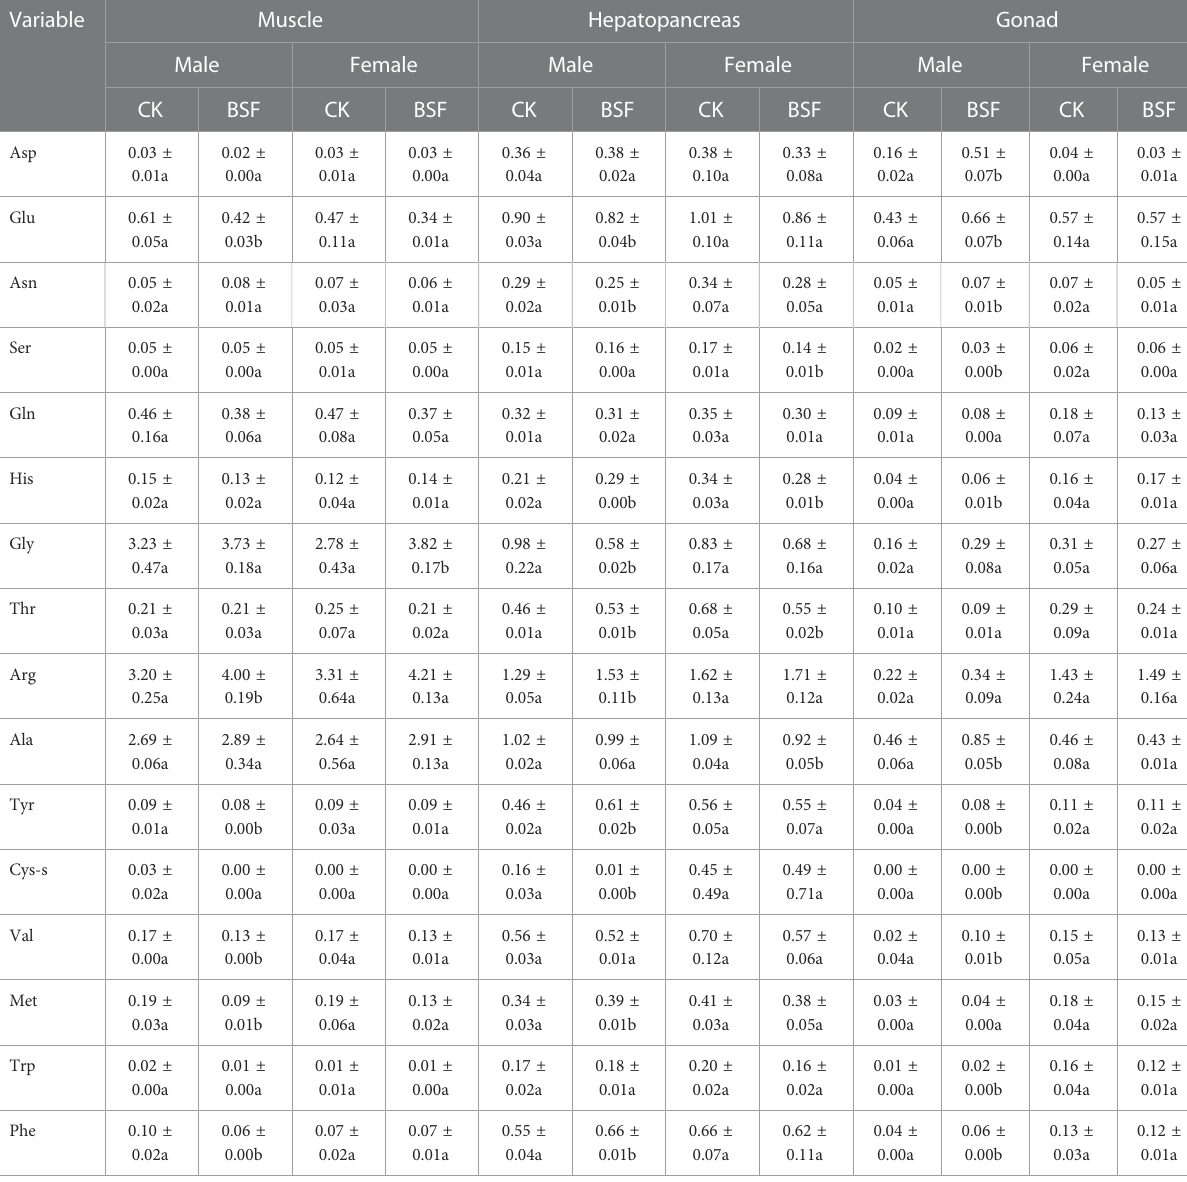
TABLE 1 Effects of BSFL feeding on amino acid concentrations in edible tissues of mitten crabs (mg/g wet weight). Variable